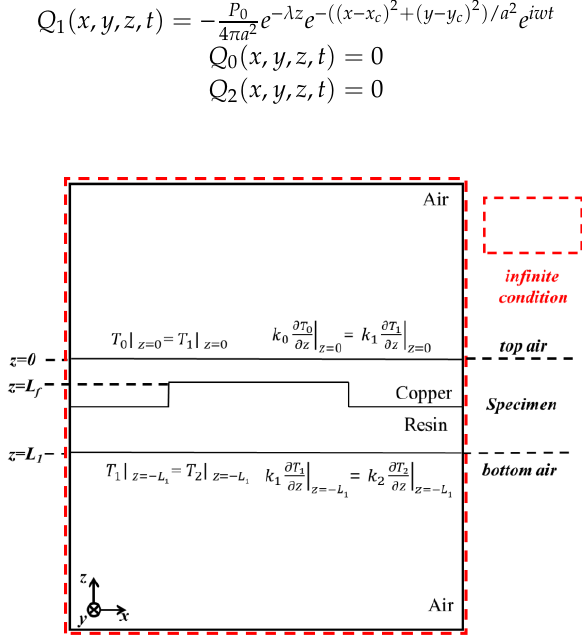
Figure 7. Boundary conditions of the numerical analysis model.